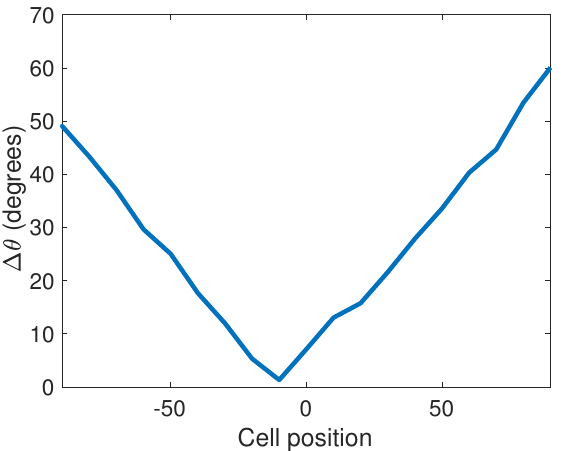
Figure 3. Relative angle between AMSR-E and moderate-resolution imaging spectroradiometer (MODIS) scans as a function of AMSR-E cell position.